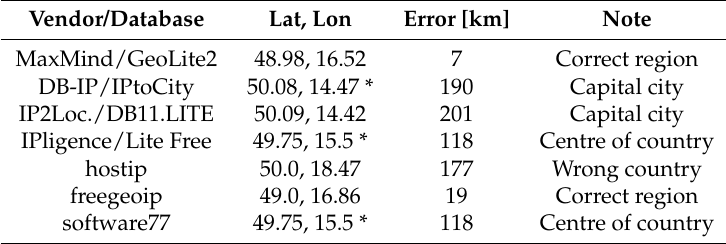
Table 2. Accuracy of locations obtained from seven free to use IP geolocation